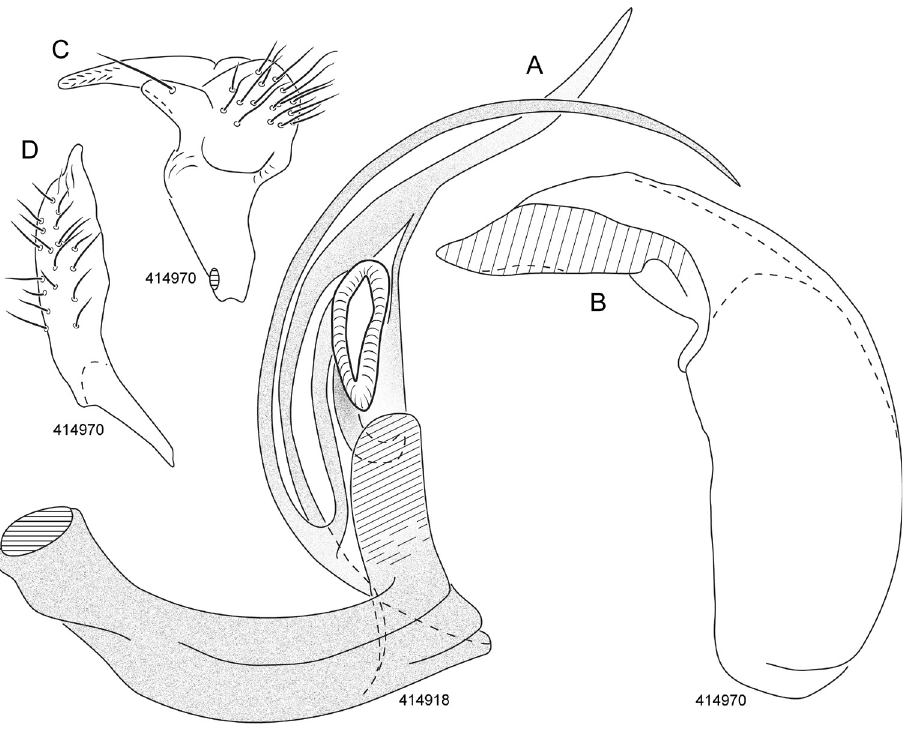
Figure 2. Male genitalia, Henryognathus thomasi . A Endosoma B Phallotheca C Left paramere D Right